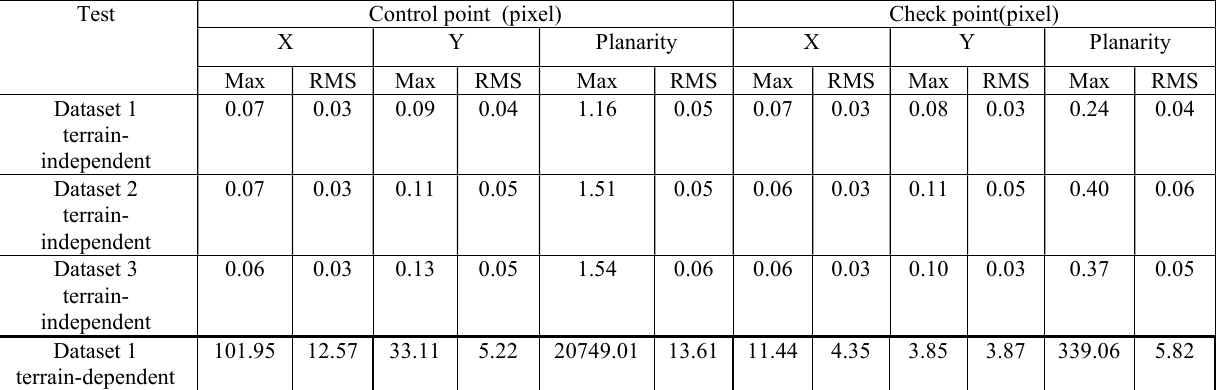
Table 6. RFM accuracy of all the